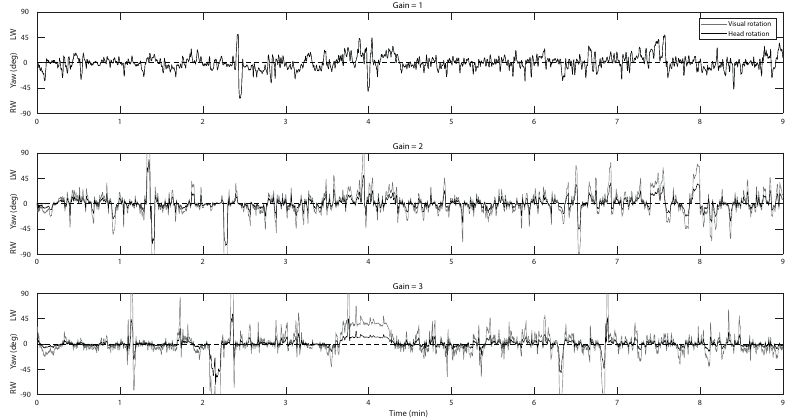
Figure 3. Example of head position recordings (black traces) during virtual biking in the 3 gain conditions in one participant (age = 81). The grey traces show the corresponding visual rotation (when the gain is 1.0, the two traces coincide). Only horizontal rotation (yaw) is illustrated. LW = leftward, RW = rightward. To facilitate comparison, the visual traces have been depicted with inverted signs (normally, visual stimulus rotation moves in the opposite direction to head